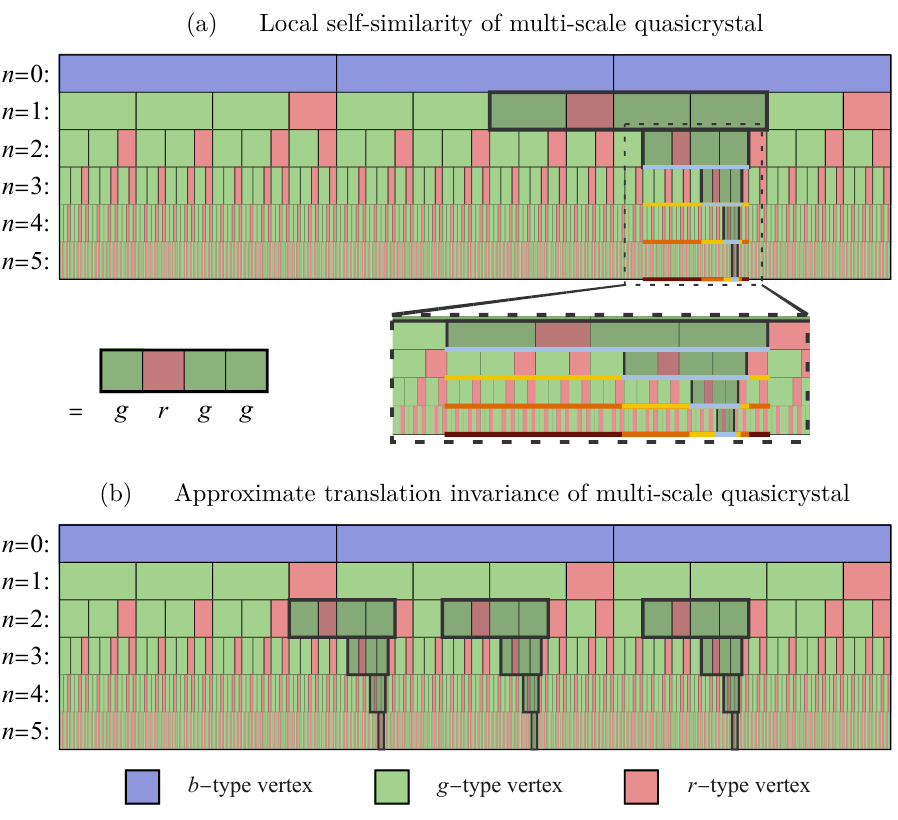
Figure 9 . Self-similarity of the { 3 , 7 } multi-scale quasicrystal ansatz (MQA). The letters b, g, r for each block are omitted, only using the colors blue, green, and red. (a) The sequence grgg (shaded blocks) characterizing one third of the total system at n = 1 inflation steps appears again as subsequences at n > 1 . This leads to a fractal self-similarity of the resulting disorder vector. The colored lines at the bottom of each inflation layer indicate the boundary subsystems of the same color in each row of figure 8(b). (b) Appearance of the sequence grgg in other subsystems at n = 2 inflation steps, with equal self-similarity on further inflation layers. In addition to the three subsystems shown, Z 3 symmetry leads to six additional repetitions. With exponentially many repeating sequences at large n , any sufficiently large boundary region is approximately invariant under